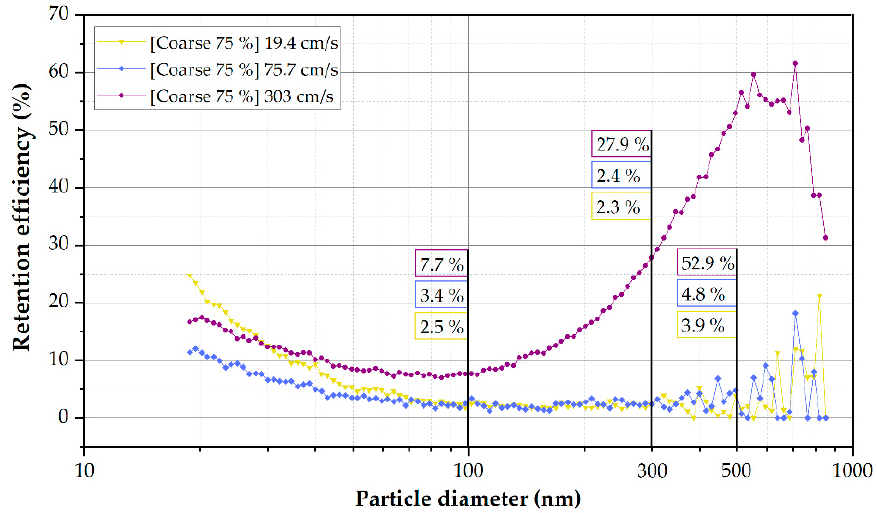
Figure 10. Coarse 75% filter retention efficiency depending on the particle diameter at different speeds (flow speeds (flow rates). Table 4. Conditions used in the filtration tests and pressure drop determination.